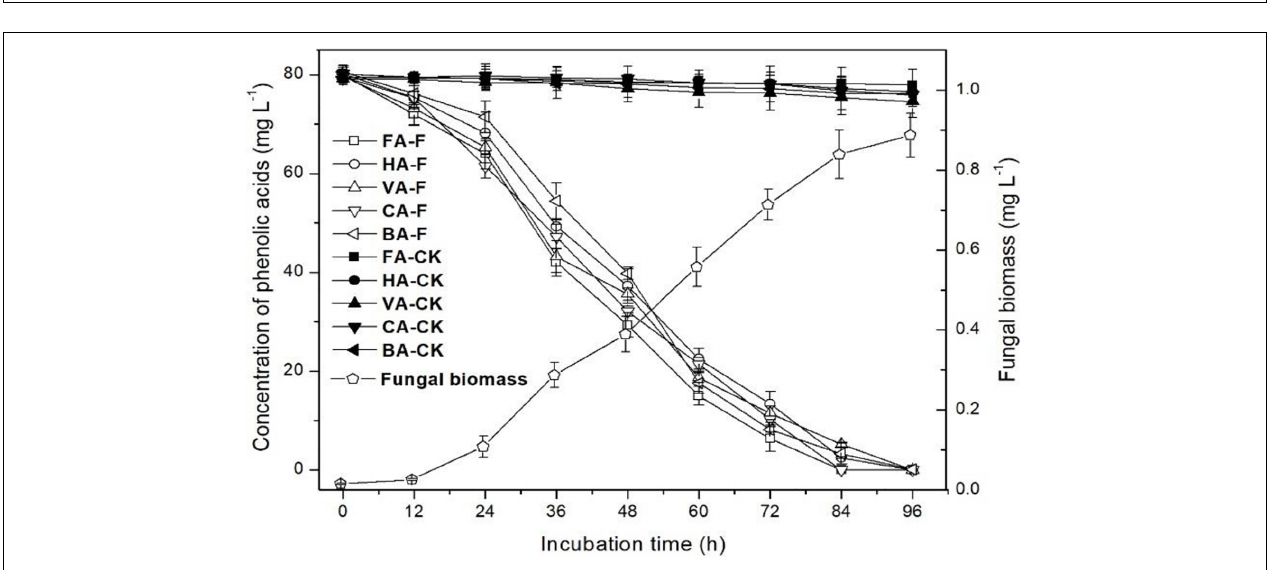
FIGURE 5 | Detection of the optimum concentration of mixture of phenolic acids for P. ostreatus P5 degradation. Data are presented as the means of three independent replicates with standard deviation bars. Data in columns marked by different letters are significantly different ( p < 0.05). “*” Indicates a significant difference from the other points ( p < 0.05).